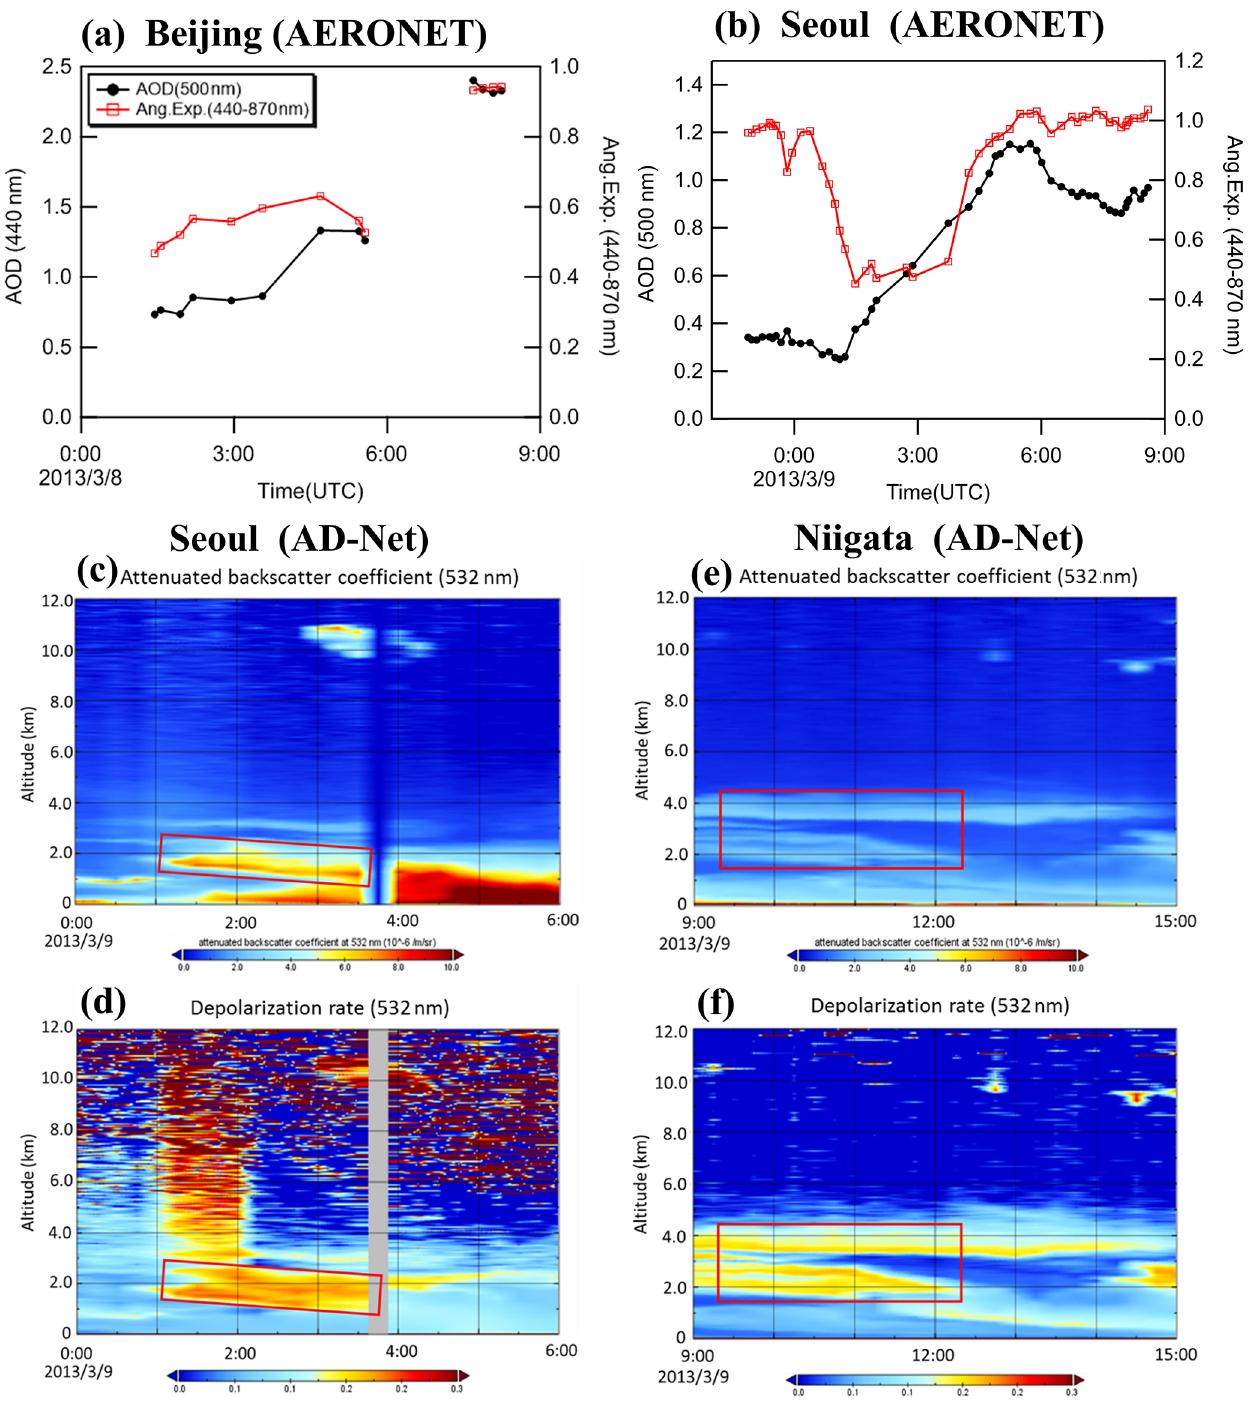
Figure 8. Aerosol optical properties observed at ground-based sites during CASE II. (a) AOD (550nm) and Angström exponent (440– 870nm) at the Beijing AERONET site, (b) AOD and Angström exponent at the Seoul AERONET site, (c–d) vertical profiles of backscattering coefficient and depolarization ratio at the Seoul AD-Net site, and (e–f) vertical profiles of backscattering coefficient and depolarization ratio at the Niigata AD-Net site. The red rectangle denotes the time when dust passed over the site.